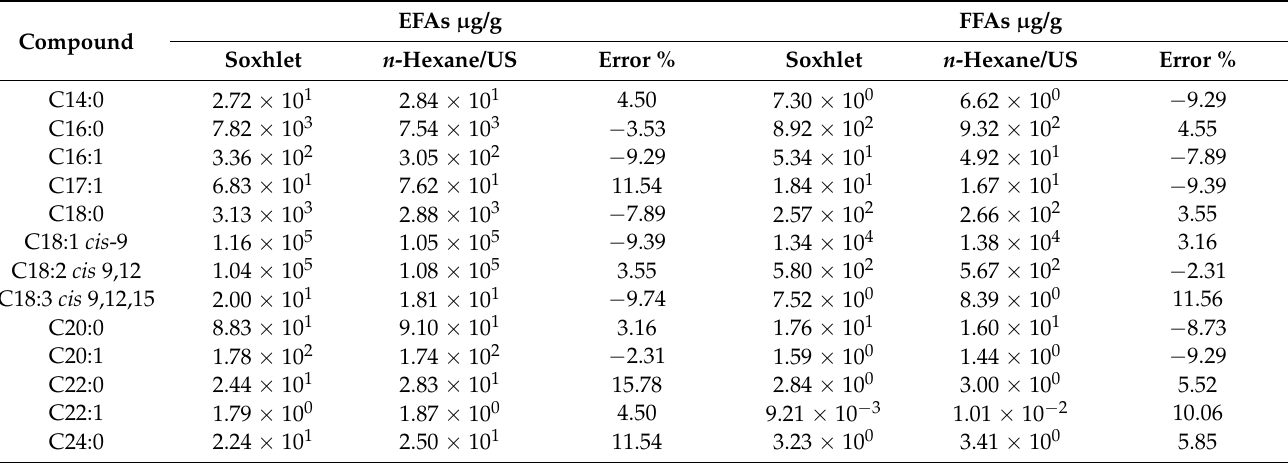
Table 3. Quantitative data for esterified fatty acids (EFAs) and free fatty acids (FFAs) from a test sample (i.e., blend of different hazelnuts). Percent error was calculated taking the AOAC 984.22 Soxhlet extraction method as benchmark.